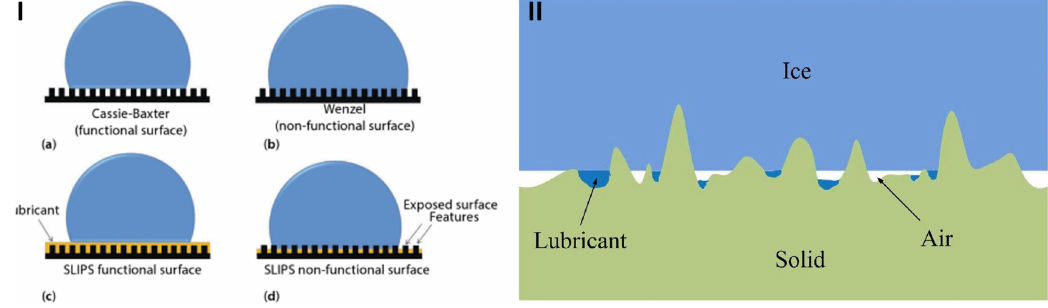
Figure 13. ( I ) Schematic for ( a ) Cassie-Baxter; ( b ) Wenzel; ( c ) functional Slippery Liquid Infused Porous Surfaces (SLIPS); and ( d ) non-functional SLIPS interfaces; ( II ) Illustration of a realistic contact pattern between ice and substrate for lubricant infused interfaces. Reprinted with permission from Refs. [151,152], respectively. c (cid:13) 2015 John Wiley & Sons; c (cid:13) 2015